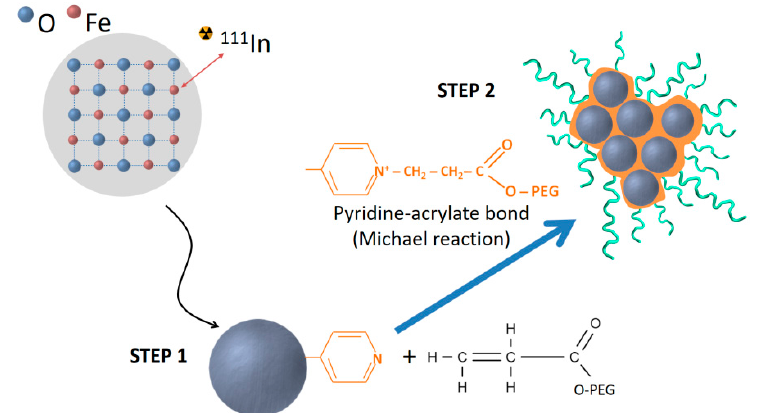
Figure 1. Schematic representation of the synthetic protocol of the iron oxide nanoparticles (IONPs). During STEP 1, small single IONPs are formed by coprecipitation and coated with P4PV. STEP 2 corresponds to the surface functionalization with acrylate terminated polyethylene glycol (PEG) through a Michael reaction with P4PV.